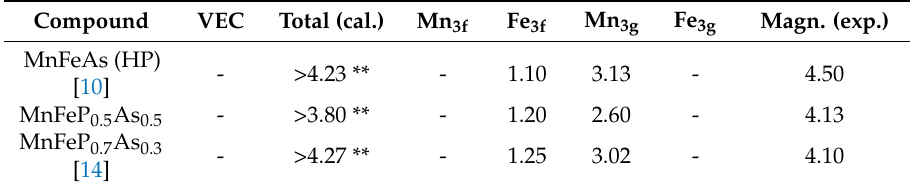
Table 6. Values of magnetic moments and magnetization found for the isotype MnFeP 1 − y As y compounds of Fe 2 P type. Compound VEC Total (cal.) Mn 3f Fe 3f Mn 3g Fe 3g Magn. (exp.) MnFeAs (HP) - >4.23 ** - 1.10 3.13 - 4.50 [10] MnFeP 0.5 As 0.5 - >3.80 ** - 1.20 2.60 - 4.13 MnFeP 0.7 As 0.3 - >4.27 ** - 1.25 3.02 - [14]